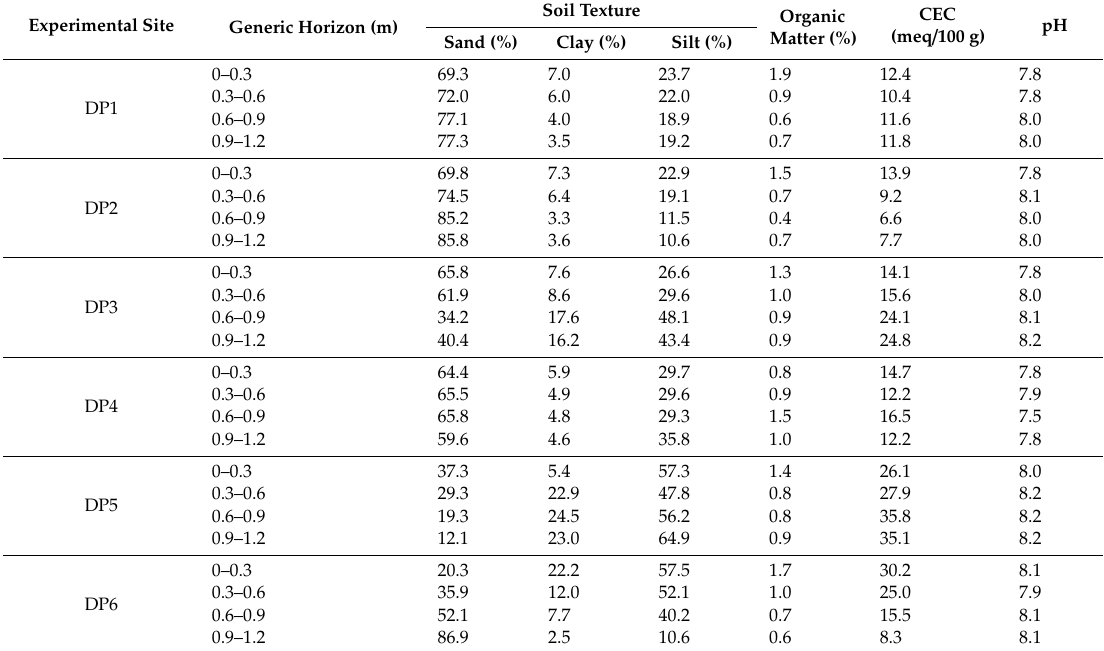
Table 2. Physical and chemical properties of the soils of the experimental sites. CEC represents the through